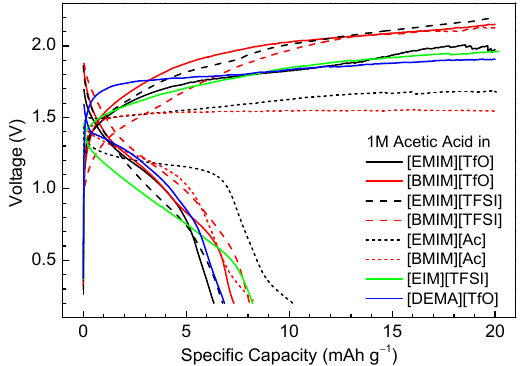
Figure 3. Electrochemical charge/discharge characteristics of nickel/metal hydride (Ni/MH) half-cells with different acetic acid/IL electrolytes at the 20th cycle. The acetic acid concentration was fixed at 1 M. Anode: AB5 MH alloy.